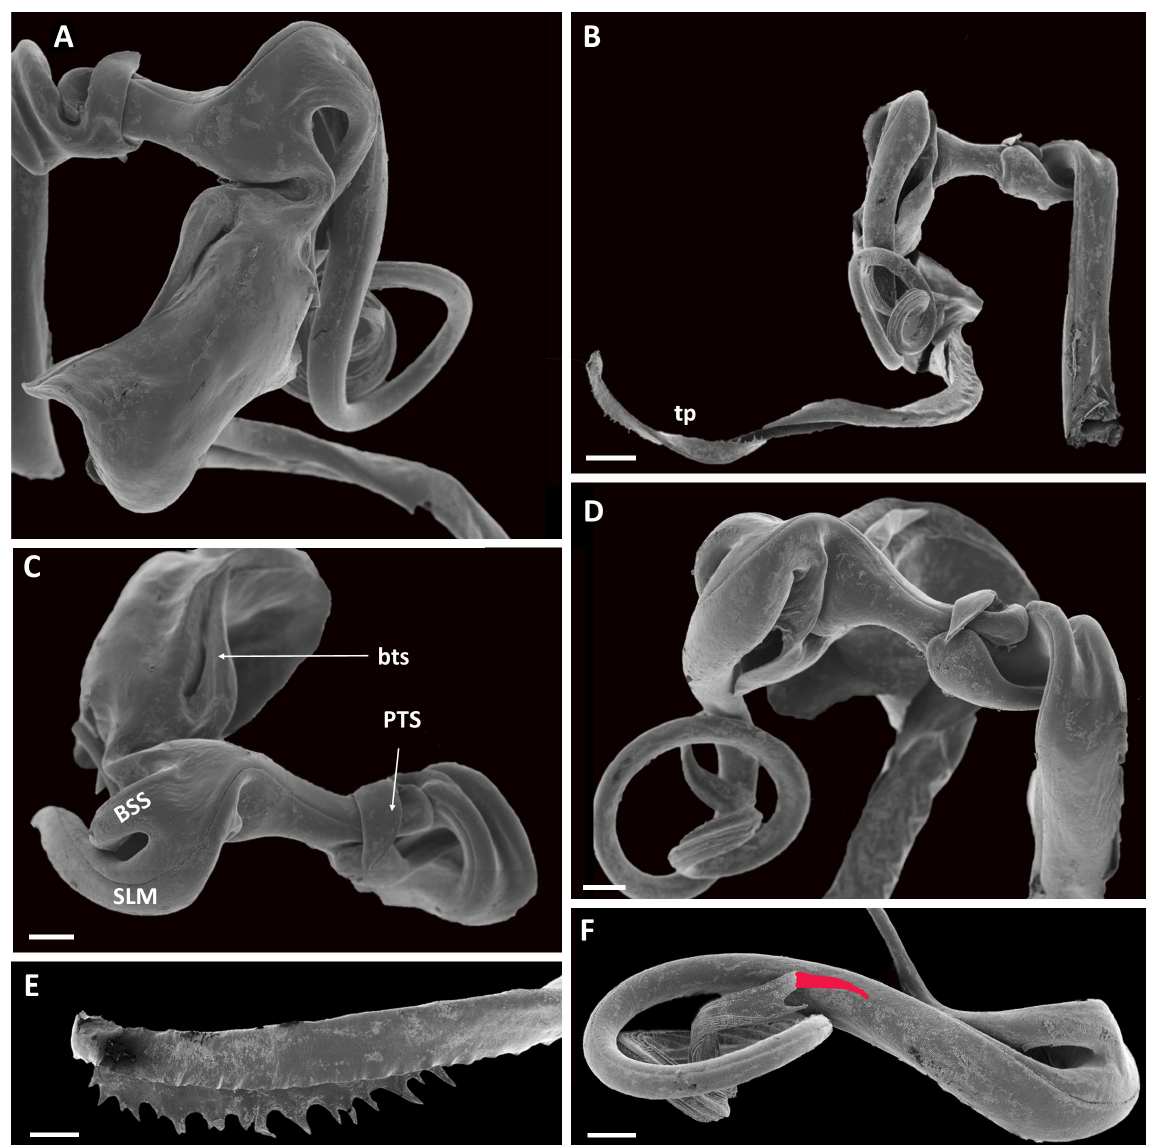
Fig. 46. Multipronopea agneteae gen. et sp. nov., paratype, ♂, from Kimboza (NHMD 621751), left gonopod telopodite. A . Anterior view. B . Posterior view. C . Apical (ventral) view. D . Meso-posterior view. E . Tip of telomere. F . Solenomere, main tip reconstructed (red). Abbreviations: BSS = basal solenomeral spine; bts = besal telomeral spine; PN = post-torsal narrowing; PTS = post-torsal spine; SLM = solenomere; TM = telomere; tp = telomeral process. Scale bars: A, C–D, F = 0.1 mm; B = 0.2 mm; E = 0.05